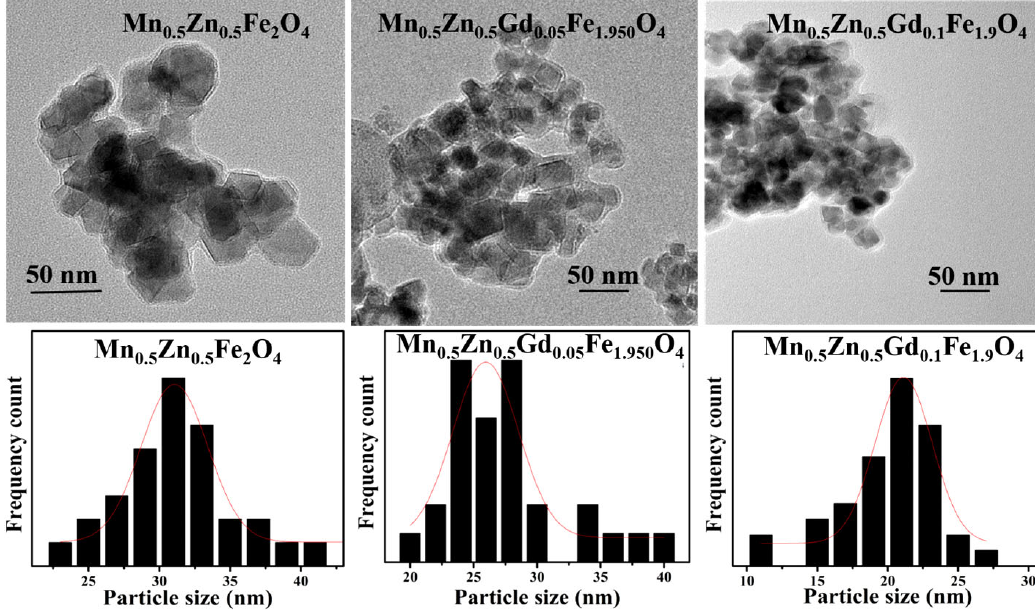
Fig. 4 TEM images of Mn 0.5 Zn 0.5 Gd x Fe 2– x O 4 ( x = 0, 0.05, and 0.1) nanoparticles along with their